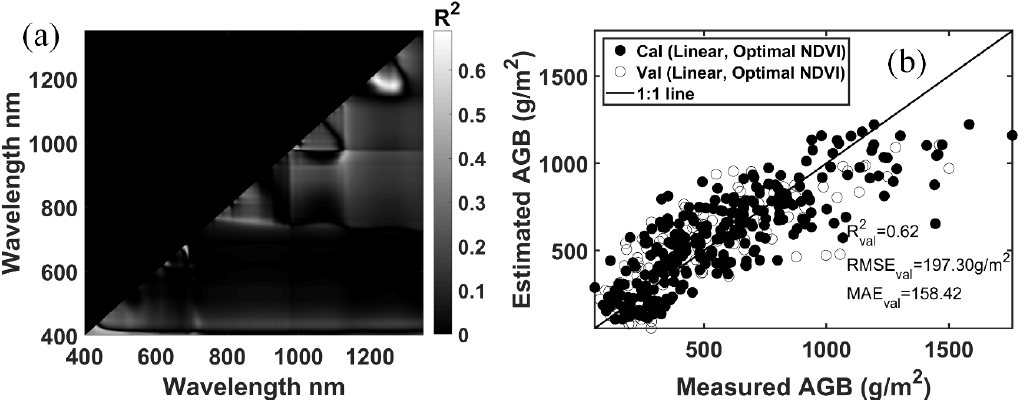
Figure 3. ( a ) Two-dimension scalogram illustrating the coefficient of determination (R 2 ) between biomass and narrowband NDVI-like indices based on all possible two-band combinations; ( b ) predictive performance of the optimal NDVI-like (1193, 1222 nm) for winter wheat biomass estimation.